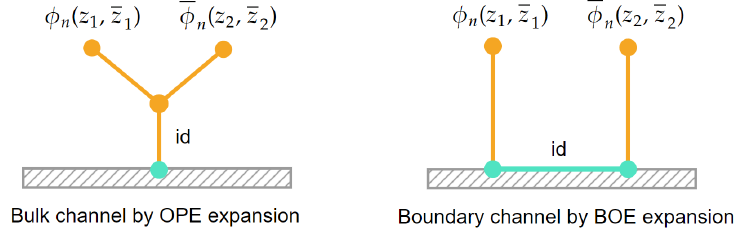
Figure 6 . The UHP two point function through different